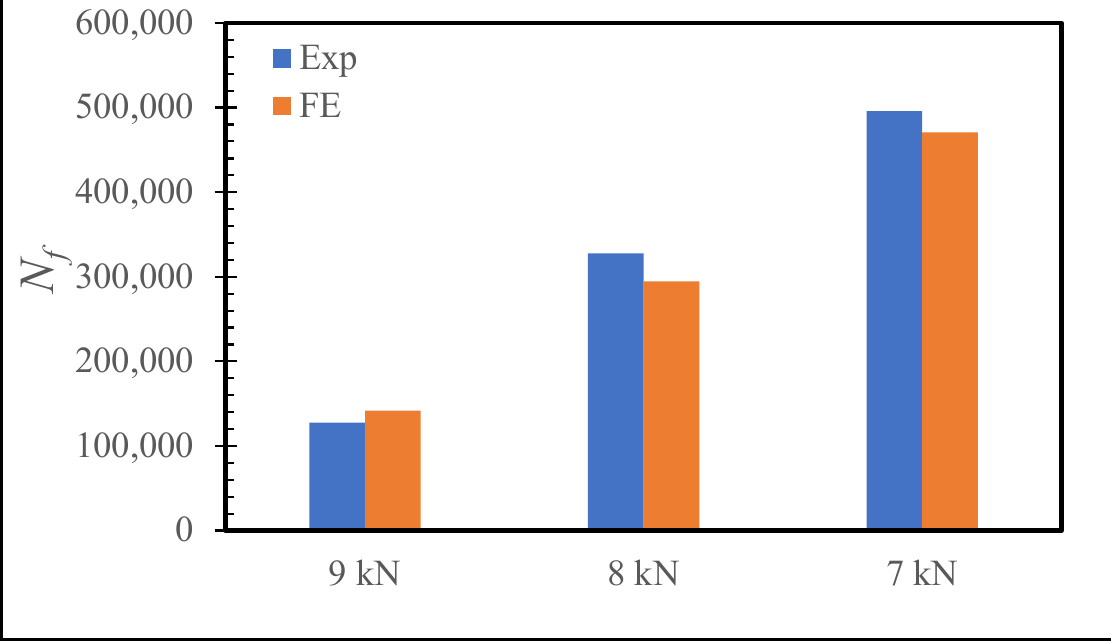
Figure 4. Number of cycles to failure ( N f ) for the three ‐ step ‐ lap joint subjected to different amounts of cyclic tensile loads obtained experimentally [15] and numerically.